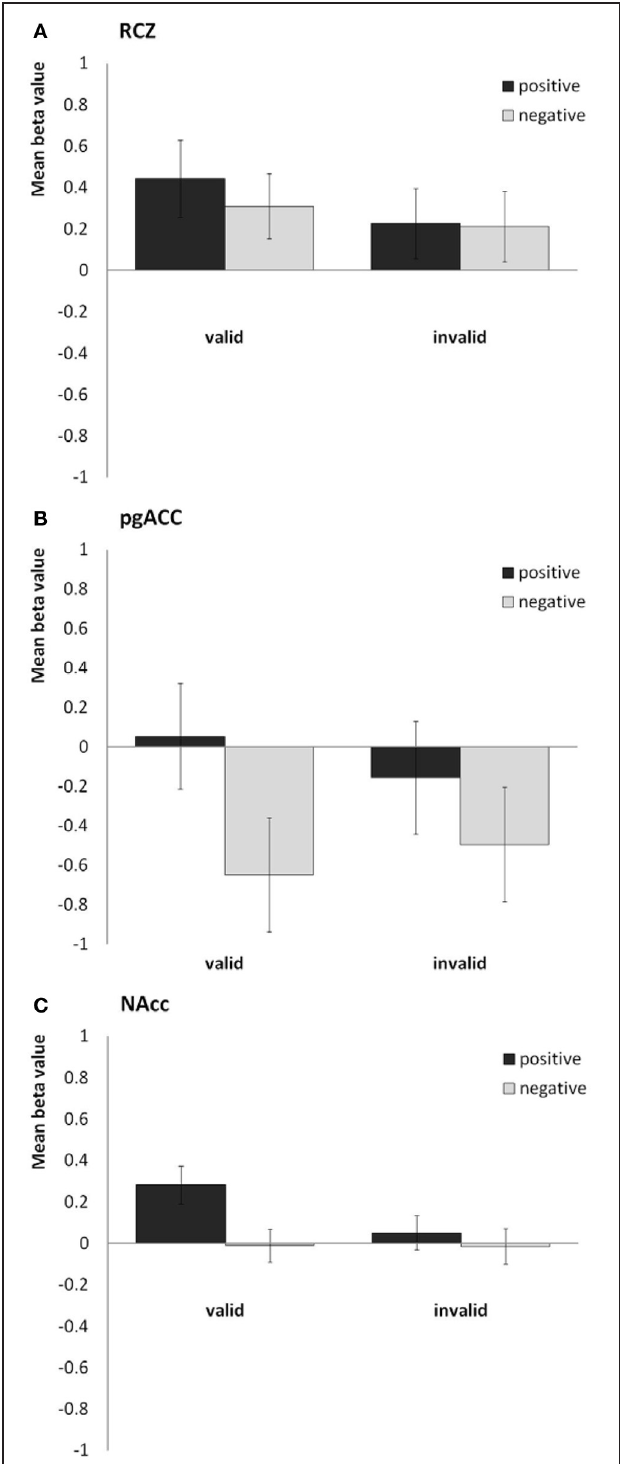
FIGURE 3 | Bar plots showing the mean beta values for the four predictors (valid positive, valid negative, invalid positive, and invalid negative) for (A) the rostral cingulate zone (averaged across the right and left hemisphere), (B) the pregenual anterior cingulate, and (C) the nucleus accumbens (averaged across both